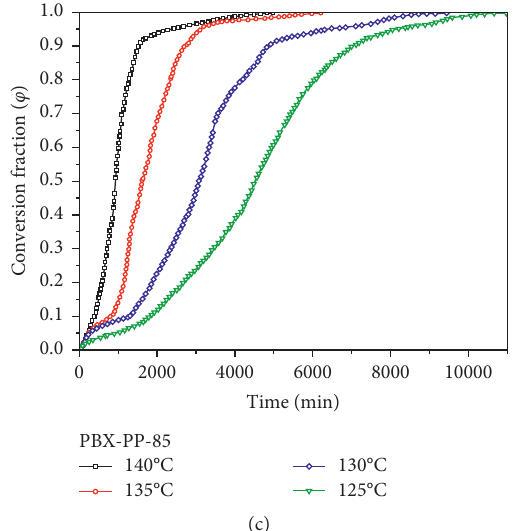
Figure 5: Conversion fractions ( φ ) versus heating time t for PBX-PN-85, PBX-PP-85, and